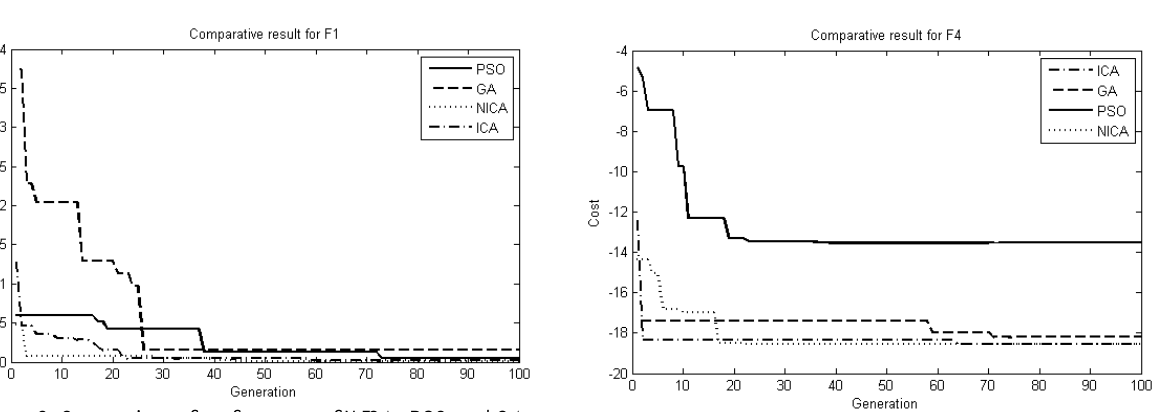
Figure 3. Comparison of performance of NICA, PSO and GA for minimization of F 1